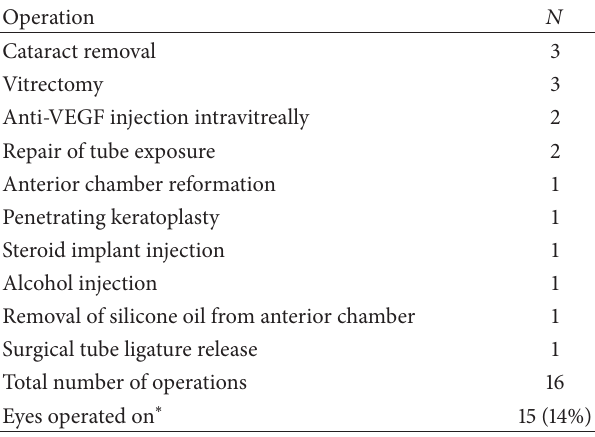
Table 4: Operations performed to treat